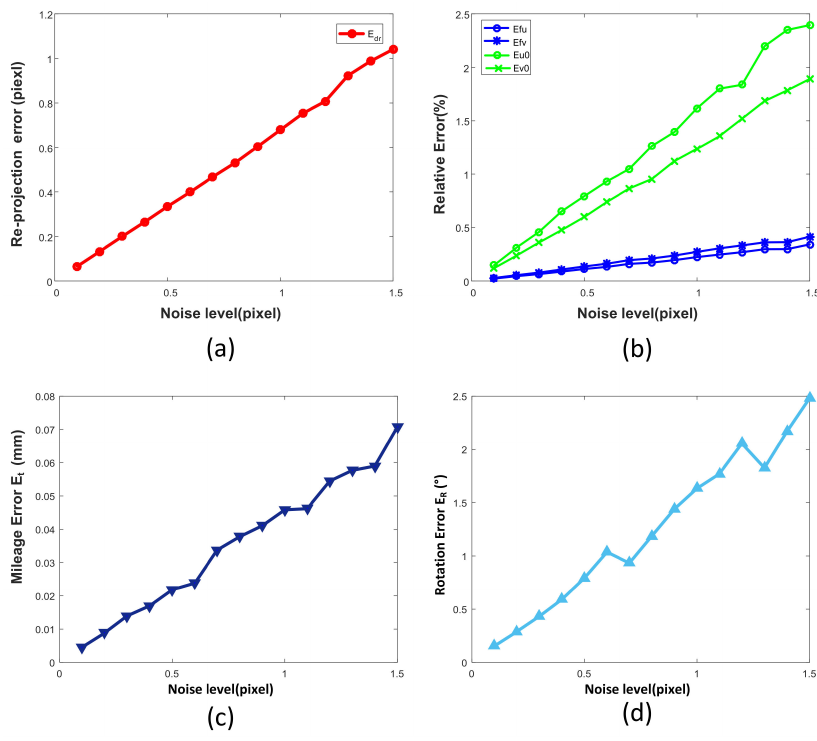
Figure 4. Simulation results for different image noise levels. ( a ) The re-projection error E dr ; ( b ) The effects of noise on intrinsic parameters such as E fu , E fv , E u 0 , E u 0 ; ( c ) mileage error E t for different noise levels; ( d ) effects of noise on rotation error E R .